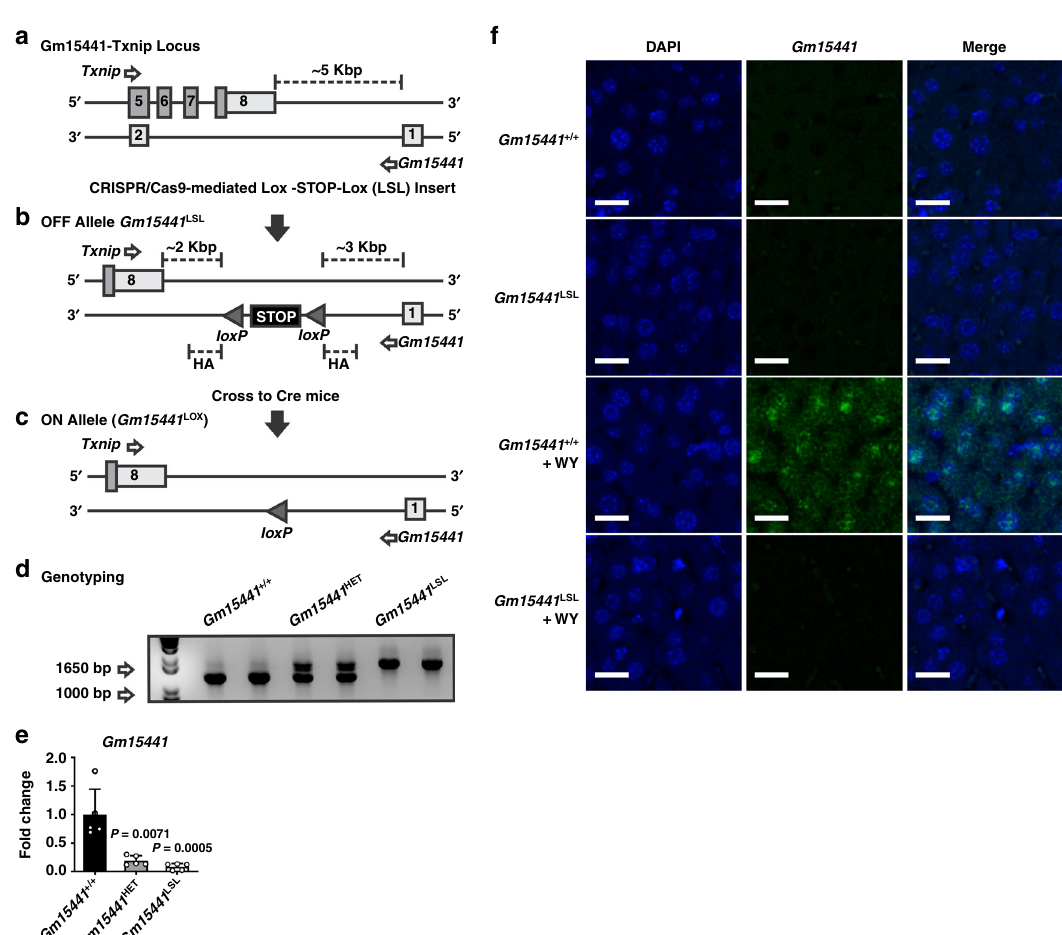
Fig. 4 Generation of the Gm15441 -null mouse line. Targeting strategy for generating a strand-speci fi c Gm15441 -null mouse line. a Exon structure of the targeted Gm15441 - Txnip locus. b CRISPR/Cas9-mediated insertion of Lox-STOP-Lox (LSL) cassette selectively ablates Gm15441 expression. c Cre- mediated removal of STOP cassette rescues Gm15441 expression. d Gm15441 knockout mouse genotyping. e Analysis of Gm15441 RNA by qRT-PCR from livers of Gm15441 + / + , Gm15441 + / − , and Gm15441 LSL mice. Each data point represents the mean ± SD for n = 5 liver samples. Adjusted p values, provided in the panels, as determined by ANOVA with Tukey ’ s multiple comparison correction, one-sided for comparisons to Gm15441 + / + mice. f Representative fl uorescence in situ hybridization staining of Gm15441 RNA in livers of Gm15441 + / + and Gm15441 LSL mice treated with WY-14643 for 48 h ( n = 5, 3 images/mouse). Scale bars represents 20 nm